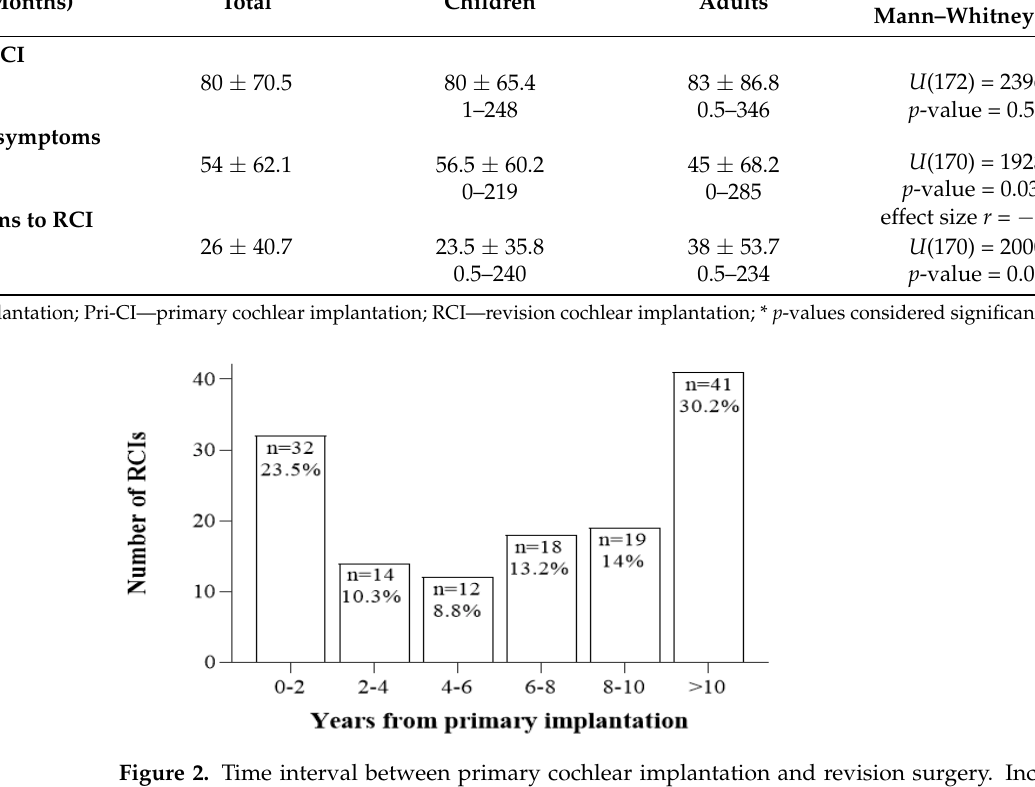
Table 1. Demographic variables.